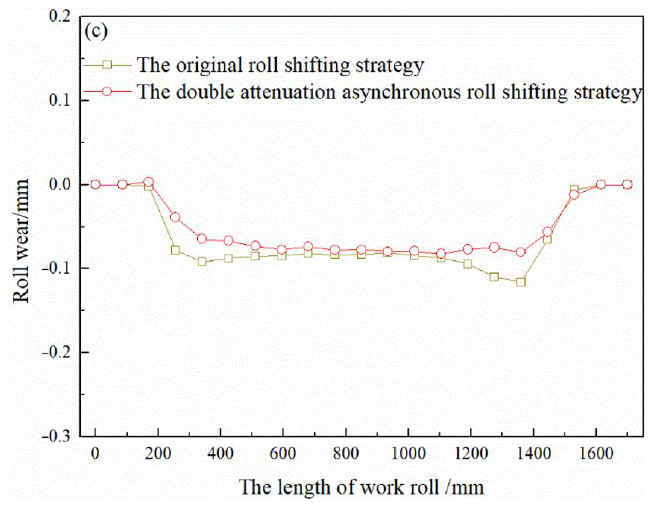
Figure 18. Comparison of work roll wear contour of downstream stands: ( a ) F4; ( b ) F5; and ( c ) F6.